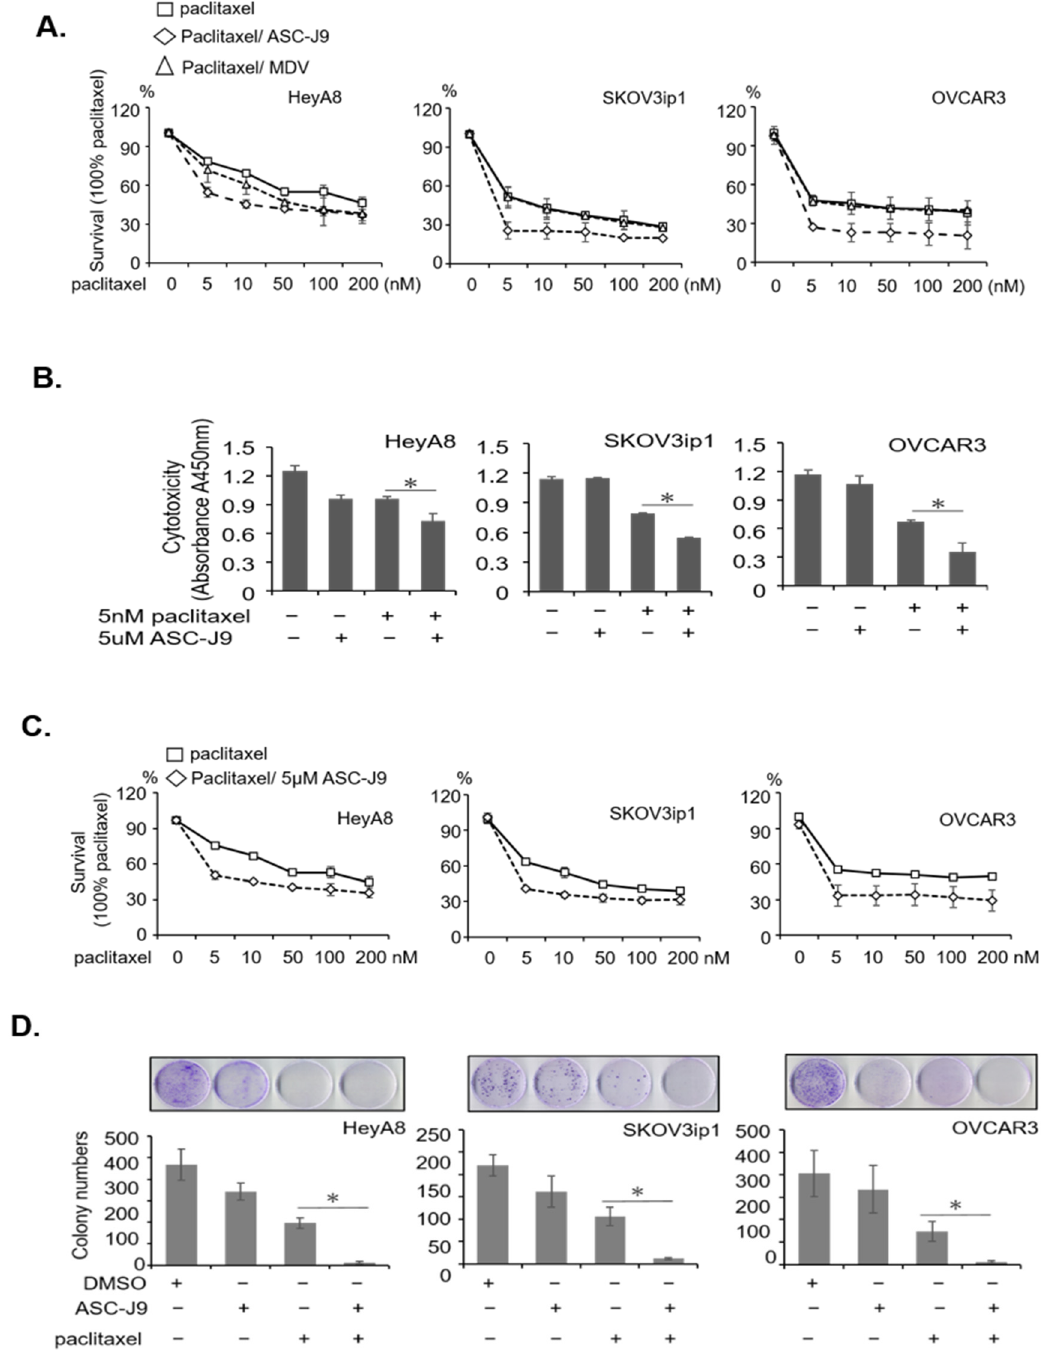
Figure 5. AR degradation compound ASC-J9 enhances paclitaxel therapeutic efficacy in vitro. ( A ) Paclitaxel and/or ASC-J9 effects on EOC serous cells. The cells were treated with paclitaxel (0, 5, 10, 50, 100, 200 nM) and/or 5 µM ASC-J9 or 10 µM MDV3100 to observe cytotoxicity. The Y axis indicates absorbance at A450 nm of WST-1 assay. ( B ) Cytotoxicity was measured in EOC cells. The Y axis indicates absorbance at A450 nm. ( C ) Dose-dependent cytotoxicity was measured in EOC cells. The Y axis indicates absorbance at A450 nm. Paclitaxel and/or ASC-J9 effects on EOC serous cells. ( D ) The cells were treated with paclitaxel (5 nM) and/or 5 µM ASC-J9 to test colony forming capacity. Upper panels show the colonies of the three EOC cell lines, and the lower panels show the quantitated number of colonies for each.